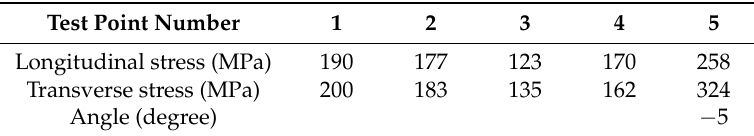
Table 10. Residual stress of longitudinal weld after enameling.